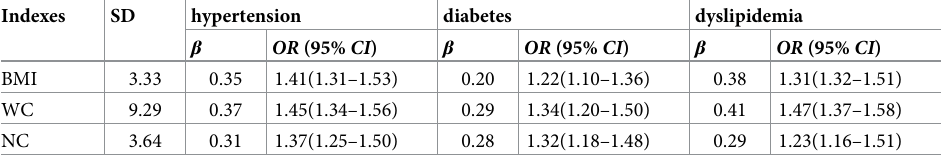
Table 4. Association of BMI, WC and NC every change of 1 SD with the prevalence of hypertension, diabetes and